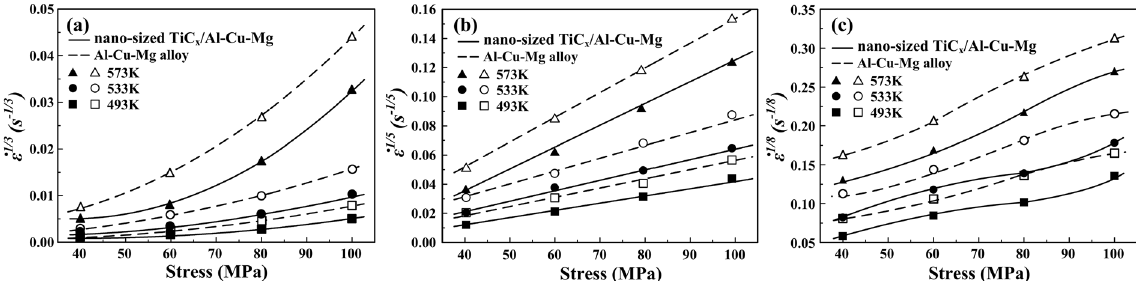
Figure 5. Lagneborg-Bergman plots of ε  n 1/ vs. stress for n = ( a ) 3, ( b ) 5 and ( c ) 8 for Al-Cu-Mg alloy and the composite,